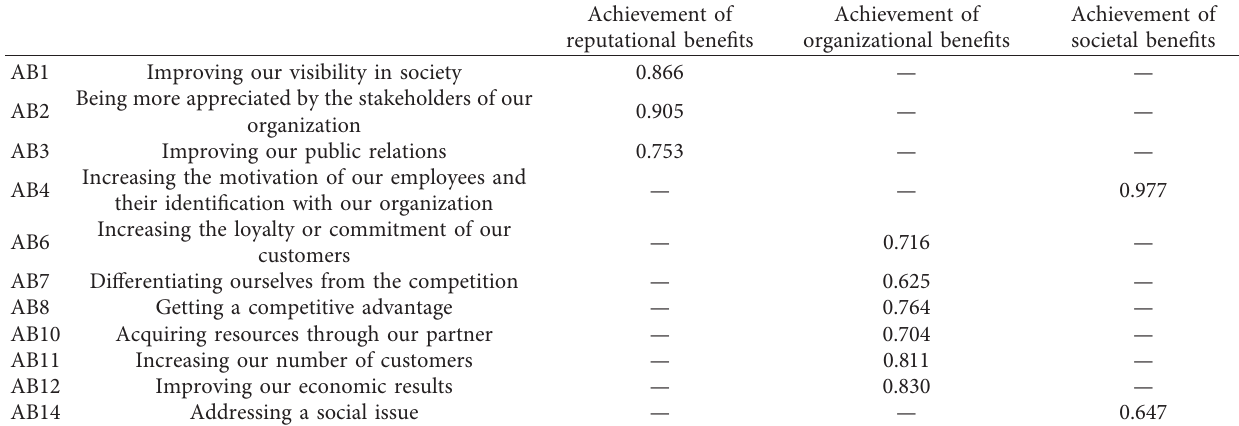
Table 5: Loadings of the indicators on the three factors considered.